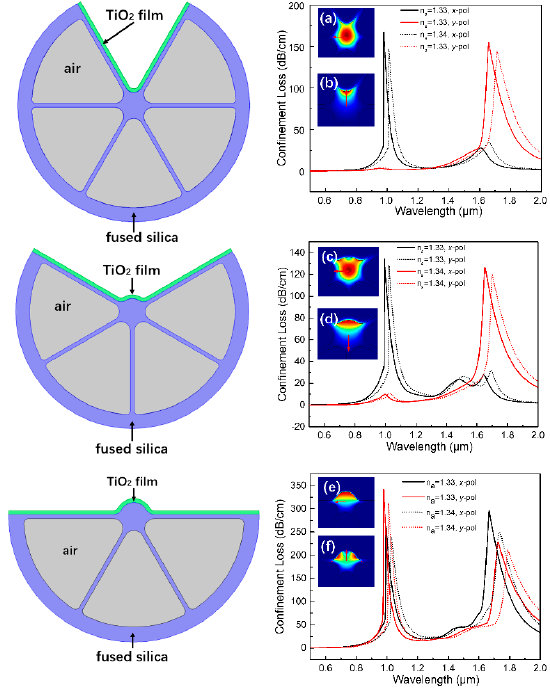
Figure 5. Loss spectra of the photonic crystal fiber (PCF) with one, two, and three air holes removed at analyte RI n a = 1.33, 1.34, respectively. ( a – f ) are the electric field distribution of the corresponding optical waveguide structures, respectively.